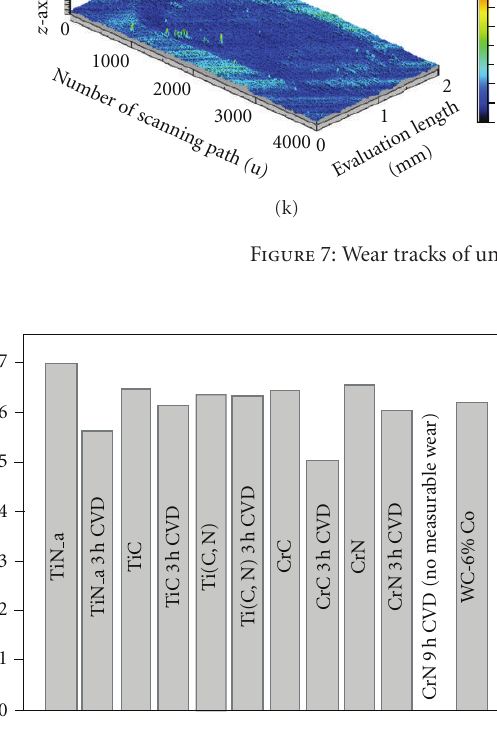
Figure 8: Wear volume of di ff erent samples submitted to dry